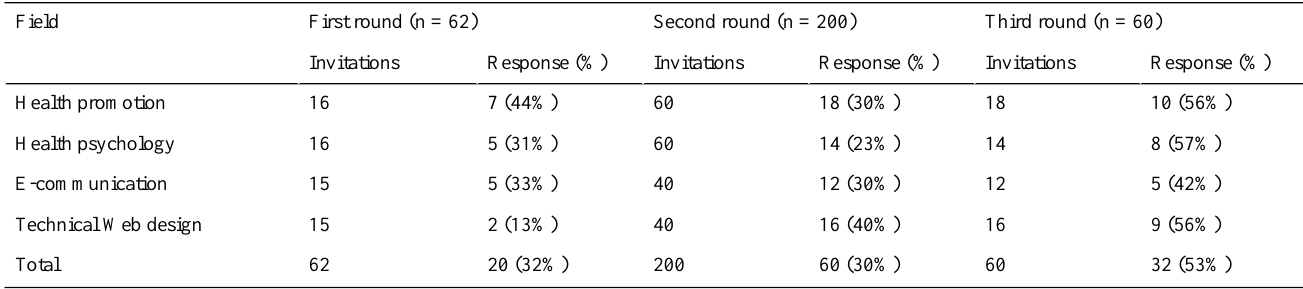
Table 1. First-, second-, and third-round rates of responses of